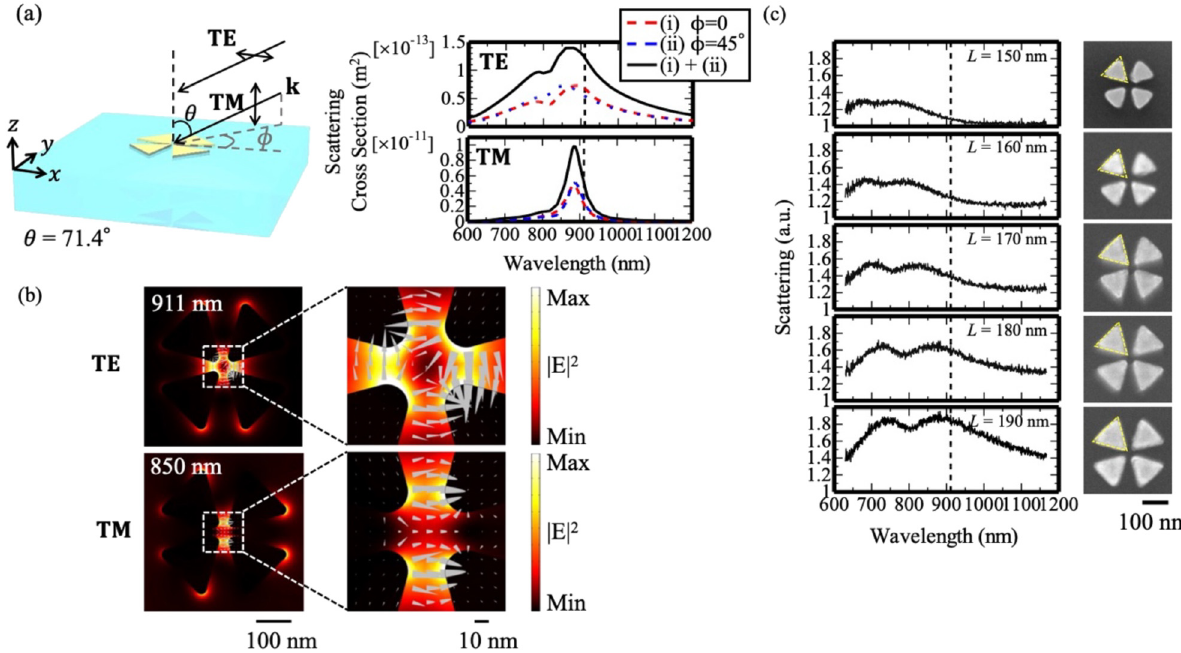
Figure 3: Results obtained under dark-field illumination. (a) Illumination configuration and numerical scattering cross-section spectra. Illumination light beams were incident from two different polar angles: ϕ = 0 ° and45 ° with two polarizations(TE andTM).Double-headed arrowindicatesthe directionof an electric fi eld.(b)Numerical near- fi eldintensitypro fi leswithasnapshotoftheelectric fi eldvectorat911nm(TE)andat850nm(TM).Thegraytrianglesindicatetheelectric fi eld vectors. (c) Experimental scattering spectra of the isolated gold tetramer with L values of 150, 160, 170, 180, and 190 nm (left) and corresponding SEM images of the fabricated samples